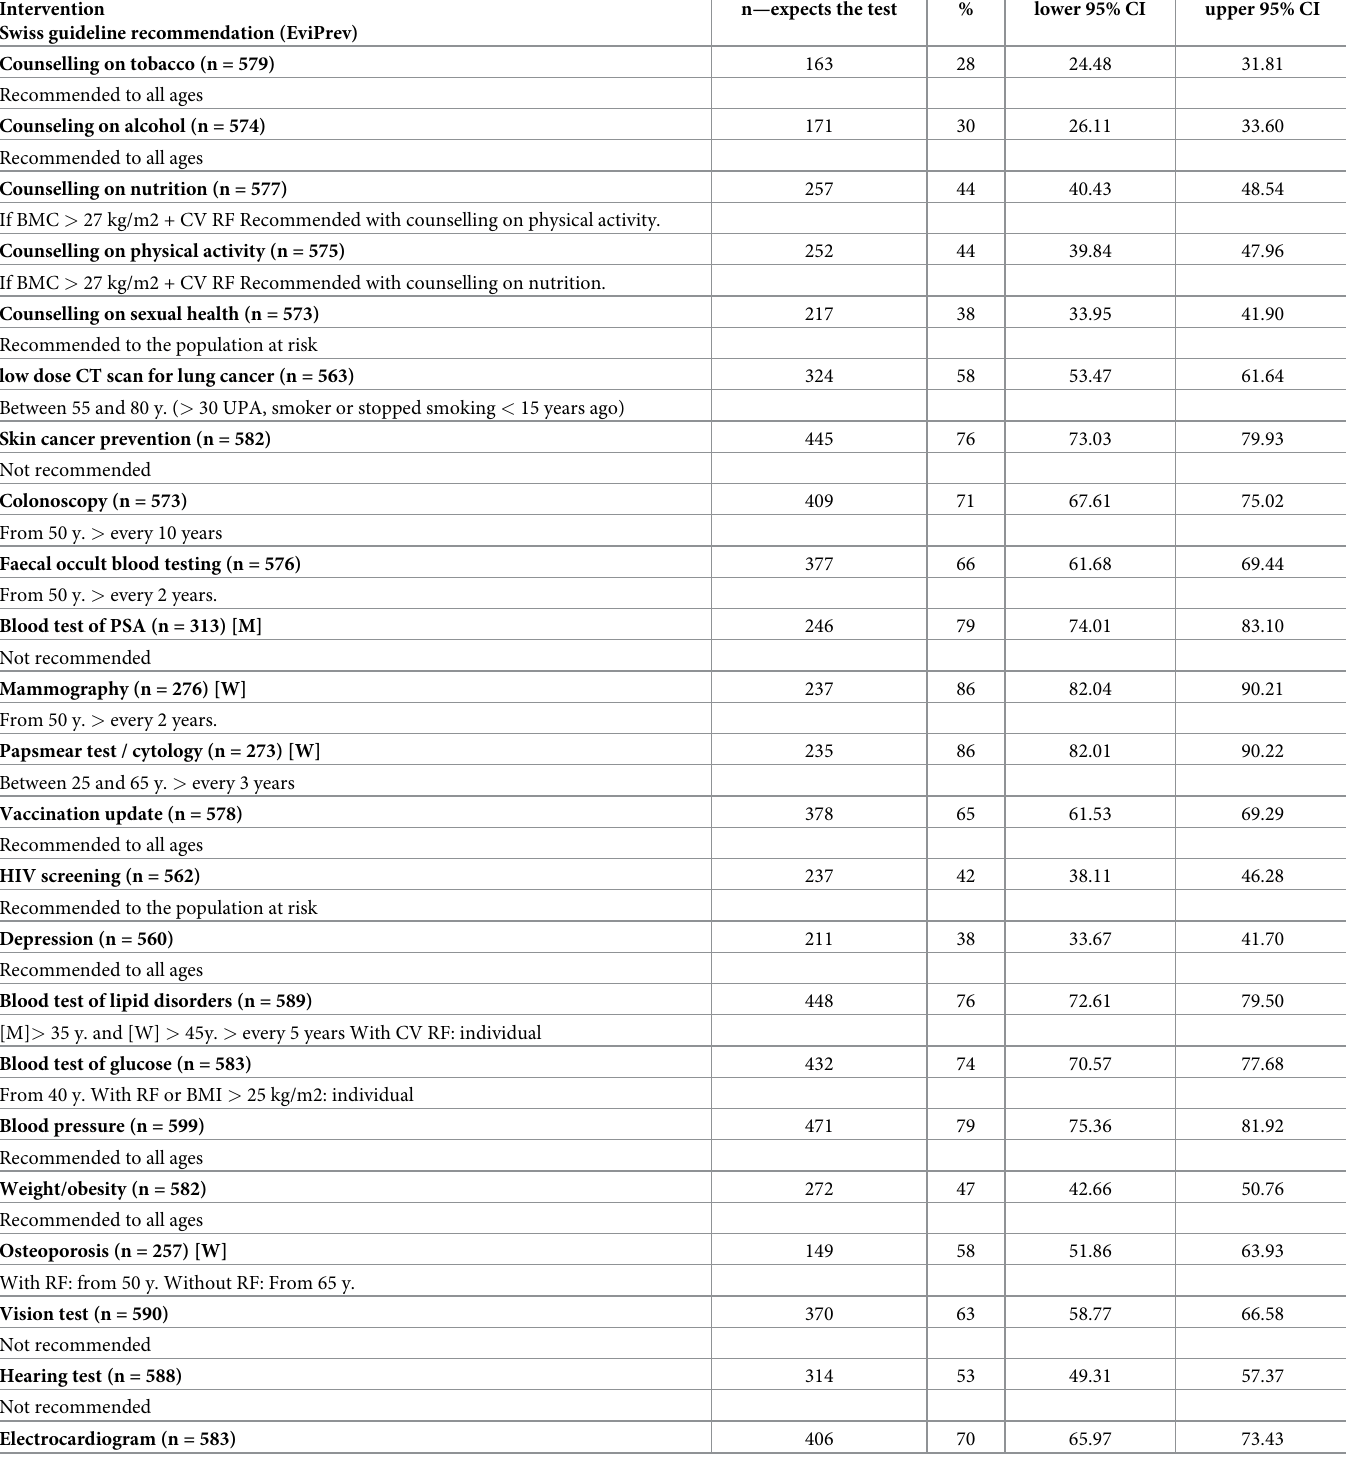
Table 5. Percentage of expected interventions and guideline